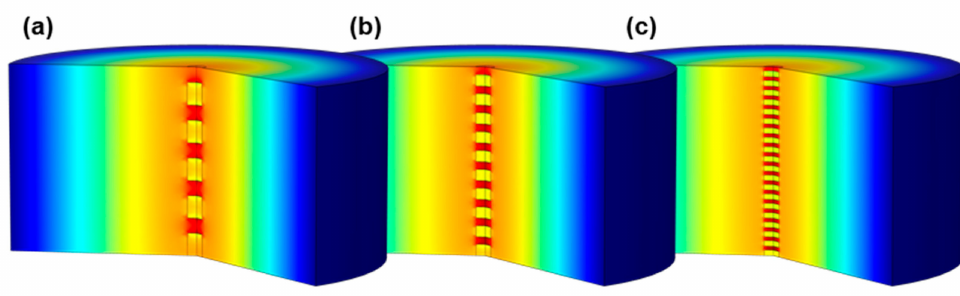
Figure 3. Simulated electric field (red: high field strength; blue: low field strength) of the TM 010 resonant mode in a rotationally symmetric resonator setup with a centered sample split into several layers ( ν bulk = 60%; σ bulk = 40 mS/m): ( a ) 5 layers, ( b ) 10 layers and ( c ) 20